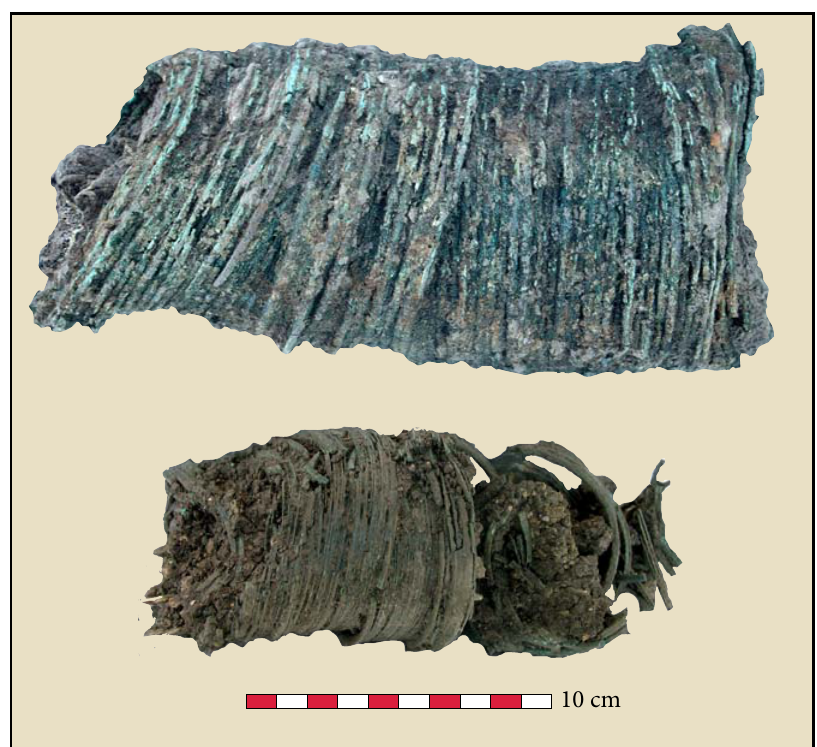
Fig. 14: Bronze bangles from Noen U-Loke burial 14 (above) and Phu Noi burial 7.